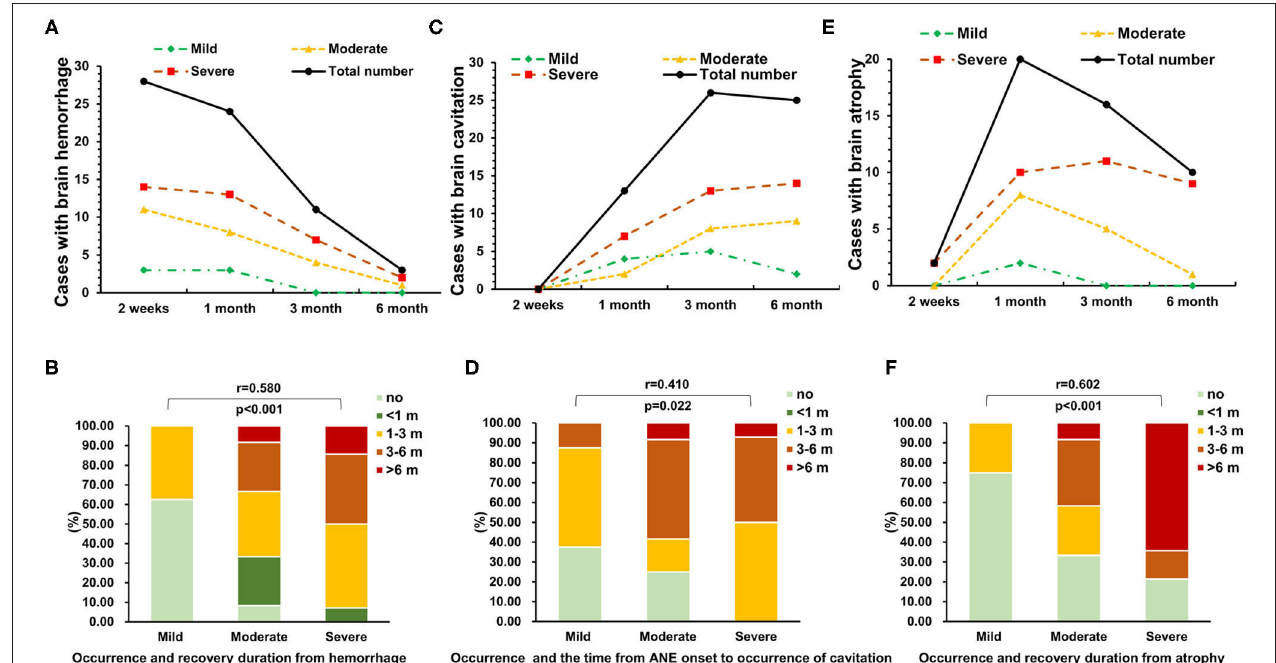
FIGURE 3 | The association of neuroimaging evolution and neurological sequelae of ANE. The dynamic changes in (A,B) brain hemorrhage, (C,D) cavitation, and (E,F) atrophy in 34 survival ANE patients with different degrees of neurological sequelae during the follow-up.